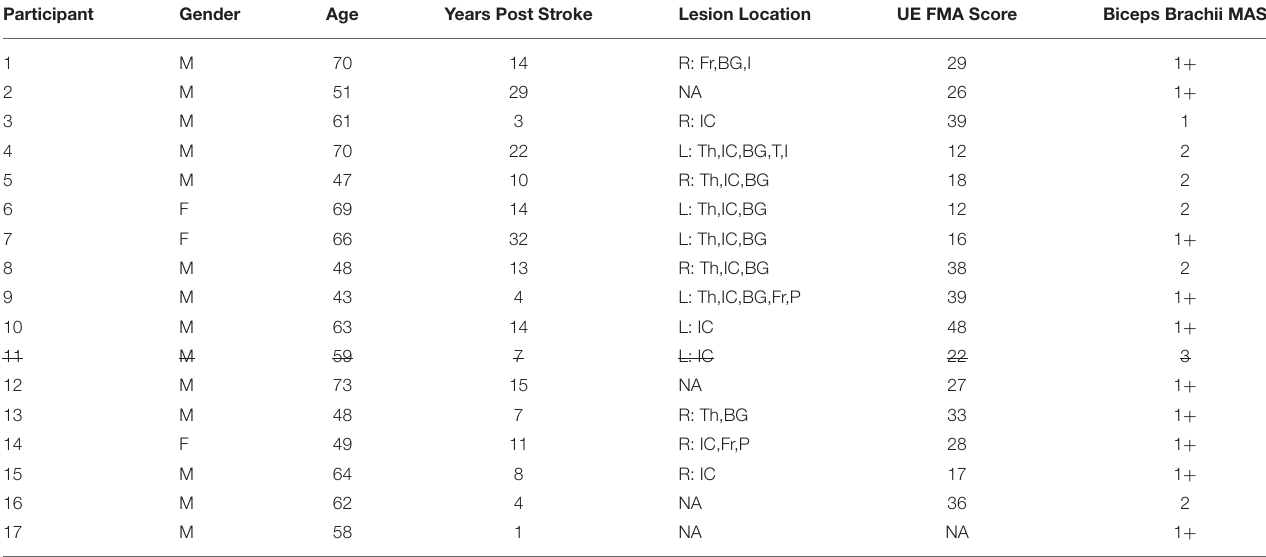
TABLE 1 | Study participants. Participant